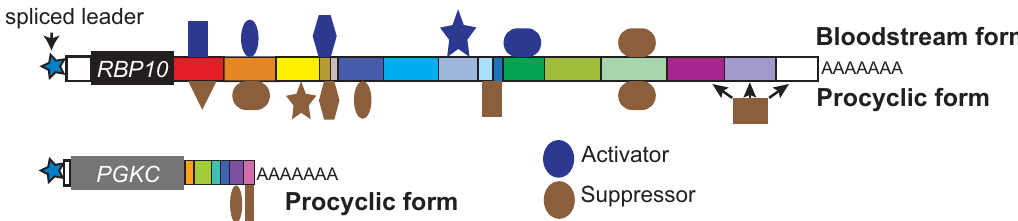
Fig 5. Model for developmental regulation of RBP10 and PGKC . The two mRNAs are shown approximately to scale, using the colour coding from Figs 2 and 3. Regulatory RNA-binding proteins that bind the the 3’-UTRs are shown schematically with different shapes; it is possible that some of them bind in more than one position. Proteins that bind but do not give strong regulation, or which compete with other proteins for binding, are almost certainly also present but are not